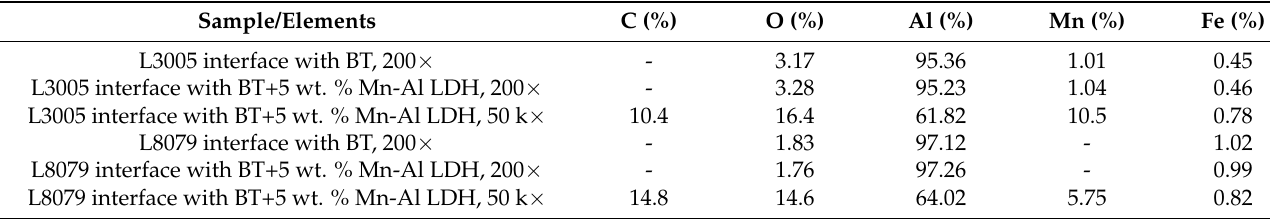
Table 5. EDS analysis of Al